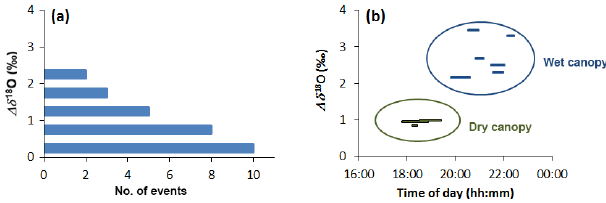
Figure 4. Difference of the isotopic signature ( (cid:49)δ 18 O) between TF and P g for (a) 28 event-based bulk samples and (b) 9 continuously analysed events of the same